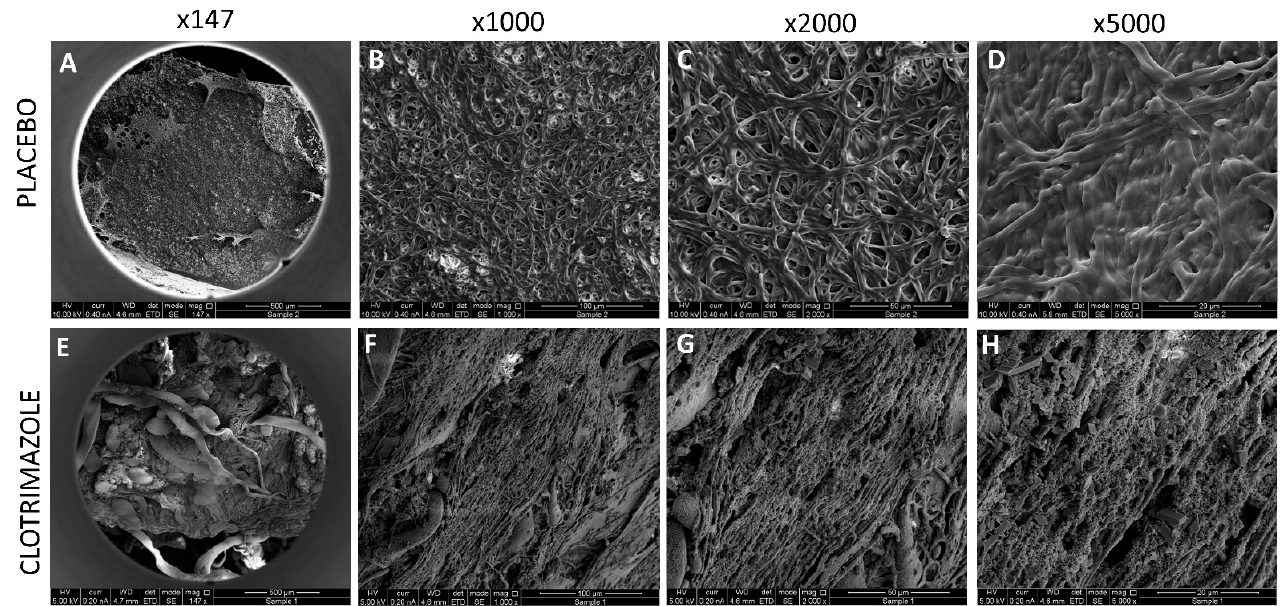
Figure 8. HR-SEM images of SRV-CTZ- versus placebo-coated VPs. SRV-CTZ- and placebo-coated VPs that have been daily incubated with fresh C. albicans cultures for 14 days were washed, fixed, coated with iridium and visualized using a FEI Magellan 400 L High-Resolution Scanning Electron Microscope. A – D ) Placebo-coated VPs. E – H ) SRV-CTZ-coated VPs. N = 1.